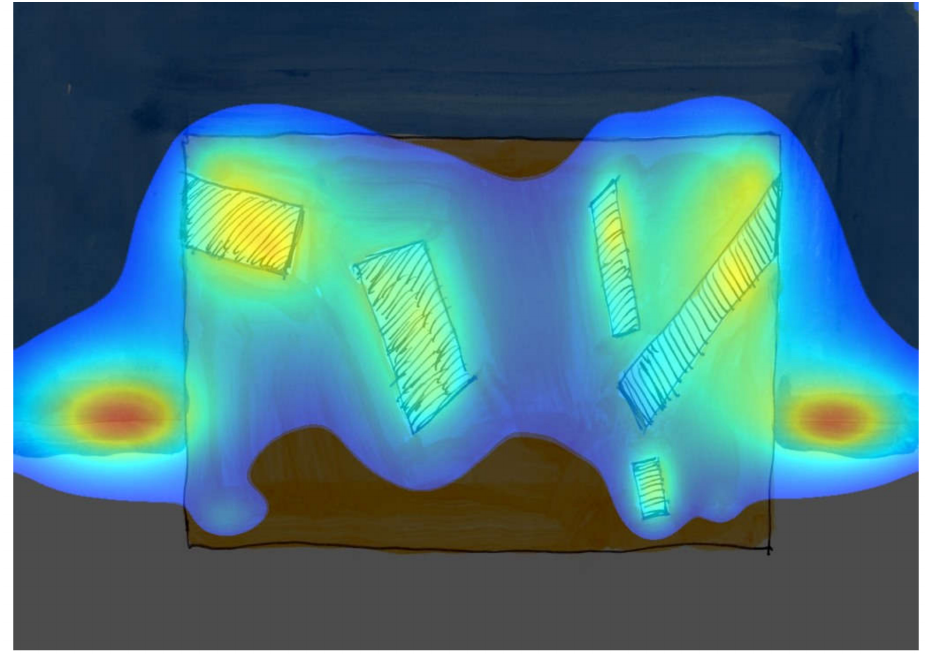
Figure 10. Heat map for contemporary building with diagonal slit